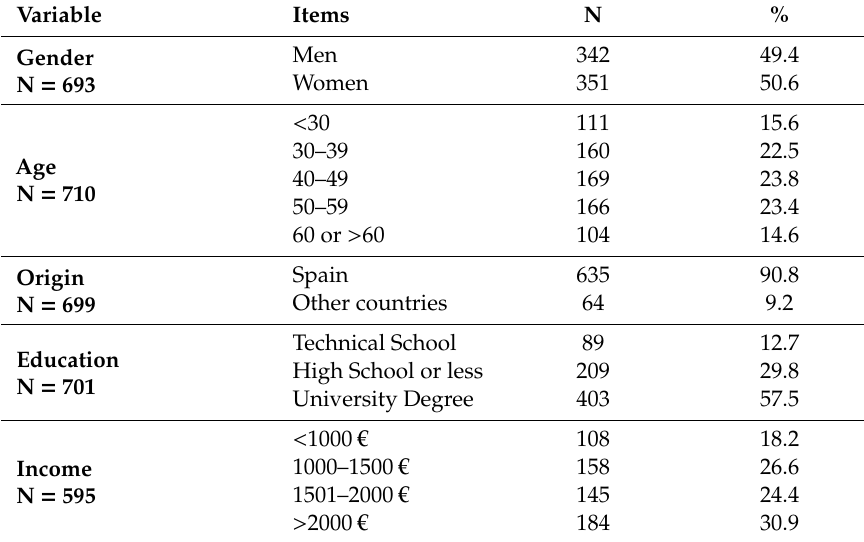
Table 3. Socio-demographic characteristics of the tourist visiting the city of C á ceres.